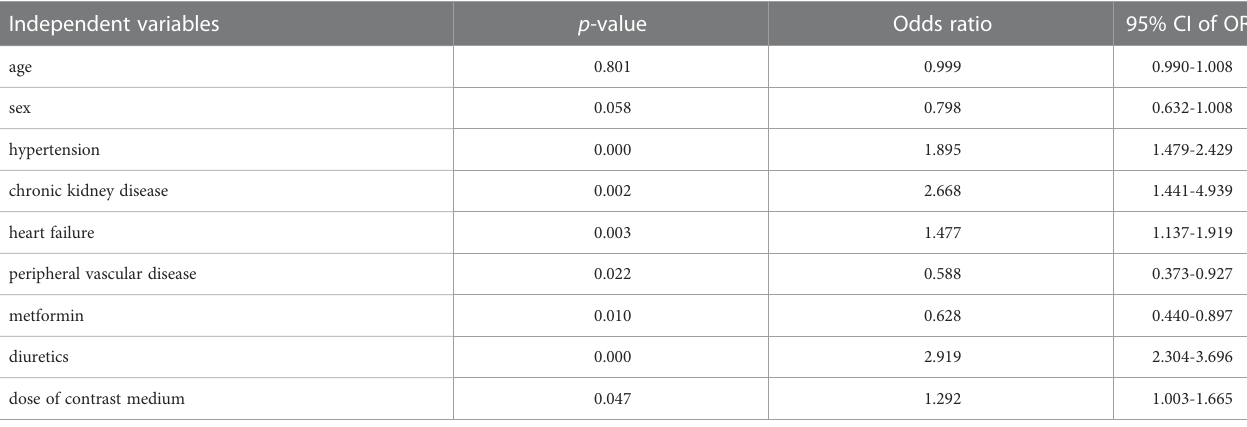
TABLE 4 Risk factors of PC-AKI using binary logistic regression